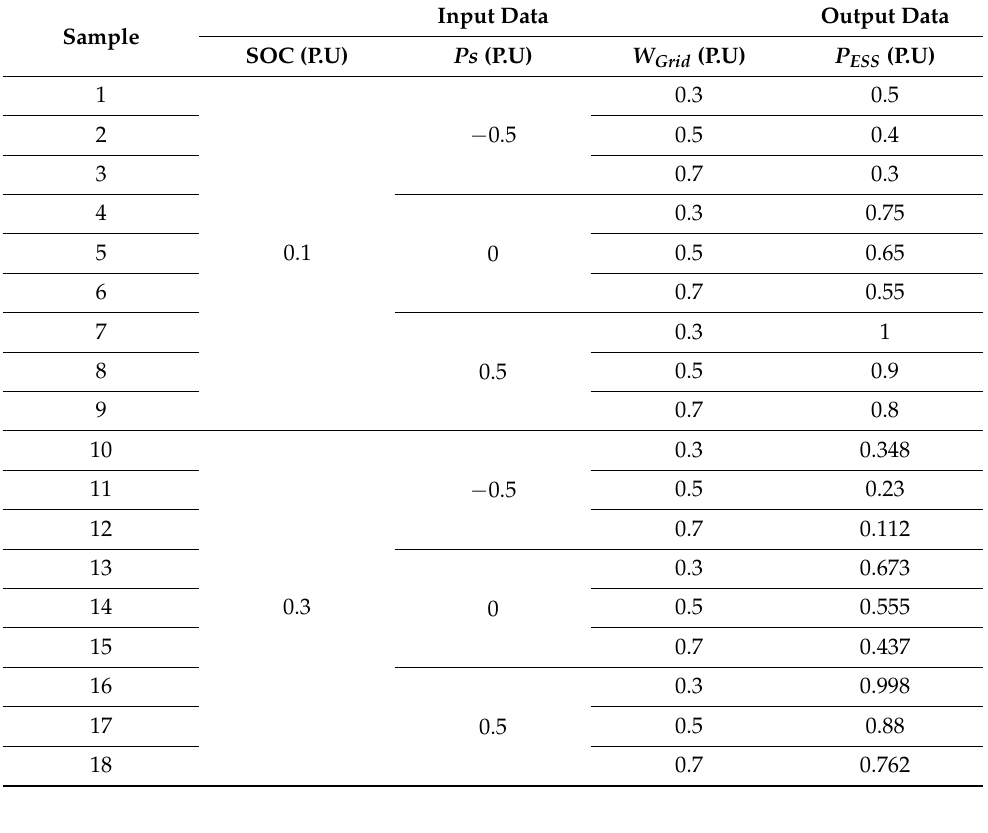
Table 1. ANN training data of mode 1.